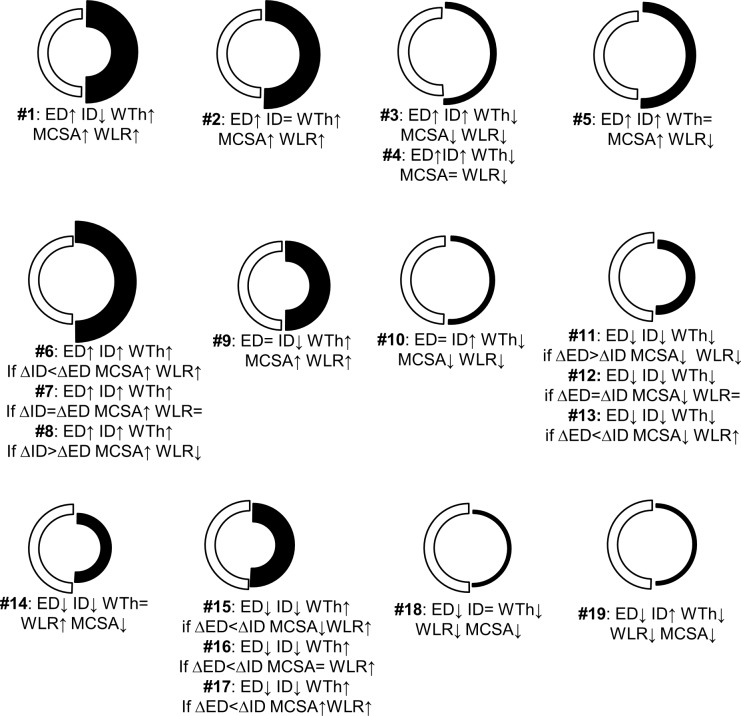
The predicted remodeling variants.The increased external diameter (ED, ↑) will develop the variants #1–8. Conformation with stable ED (=) could follow only through the variants #9 and 10. Reduction in ED (↓) could follow the variants #11–19. ID–internal diameter; WTh–wall thickness; MCSA–media cross sectional area; WLR–wall-to-lumen ratio. White semicircles–normal, black–predicted remodeling variants.